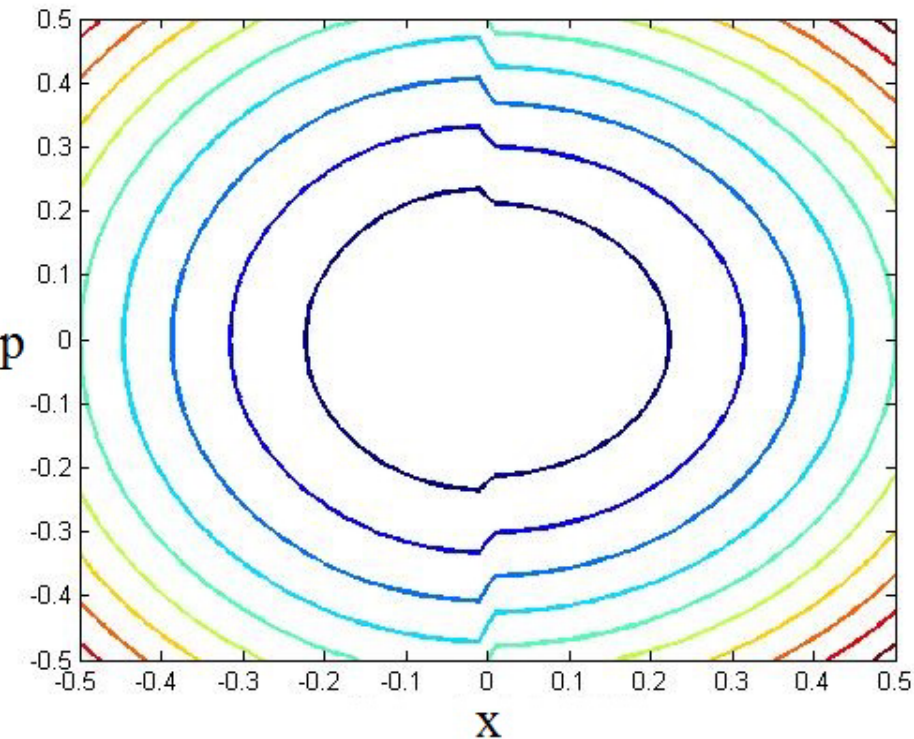
Figure 5. Phase portrait of the PDM Hamiltonian associated with single well potential for λ = 0.1.